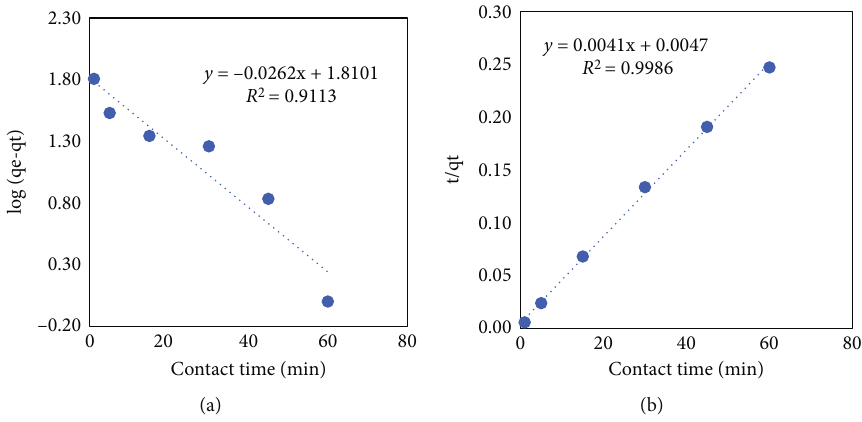
y = –0.0262x + 1.8101 R 2 = 0.9113